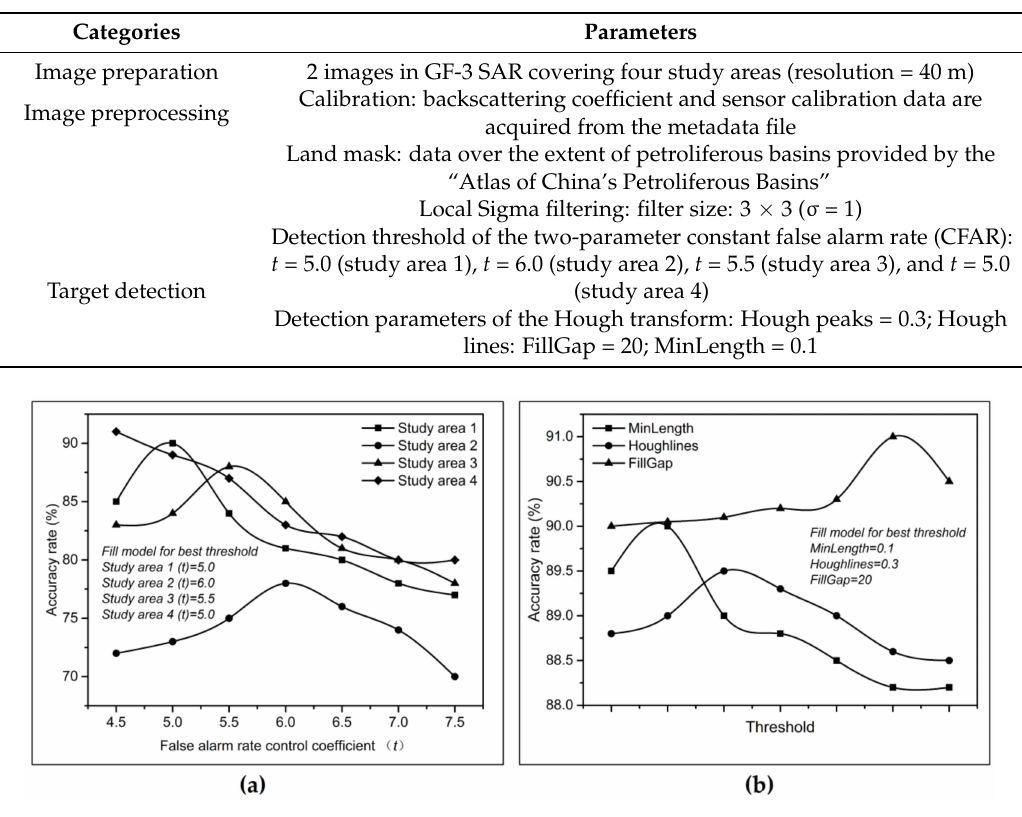
Figure 9. Optimal parameter comparison graph of the two-step correction model, where ( a ) shows the optimal detection threshold of the two-parameter constant false alarm rate (CFAR) algorithm in the four study areas and ( b ) shows the optimal detection threshold of the Hough transform in this